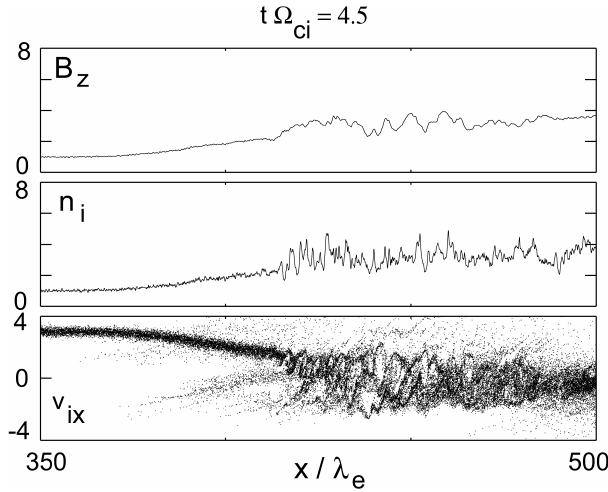
Fig. 10. Same as Fig. 10 at at t(cid:127) ci = 4 . 5.